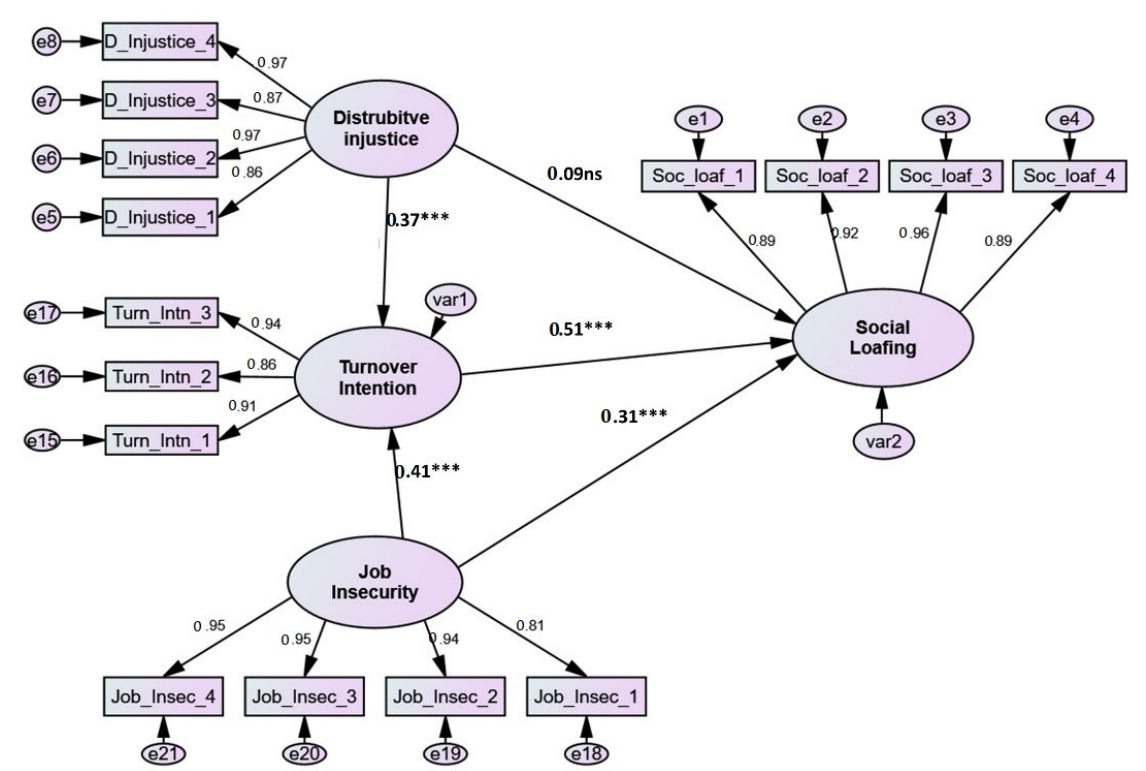
Figure 2. The structural mode. ***: p < 0.001.